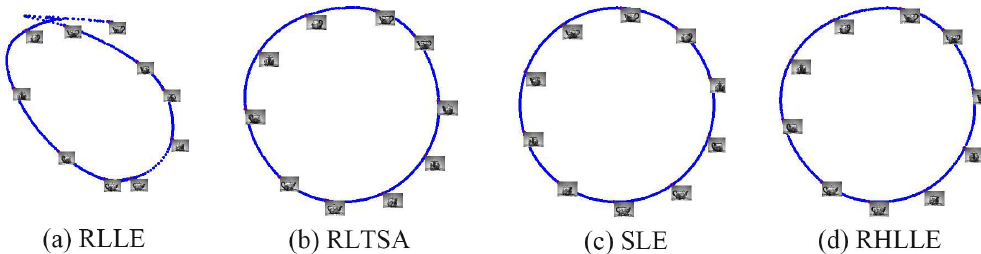
Figure 8. 2D embedding results of RLLE, RLTSA, SLE and RHLLE on the original teapot image set without being